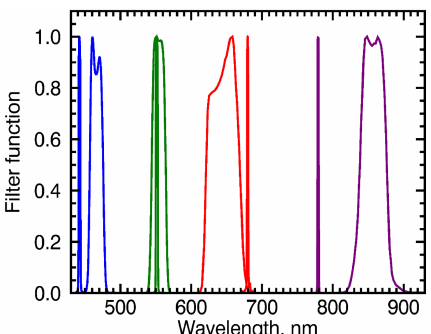
Figure 3. EPIC (narrow) and MODIS (wide) filter functions nor- malized to the maximum value for the four channels used in this